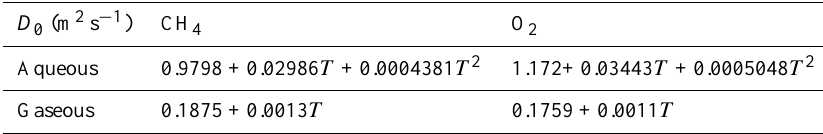
Table 2. Temperature dependence of aqueous and gaseous diffusion coefficients for CH 4 and O 2